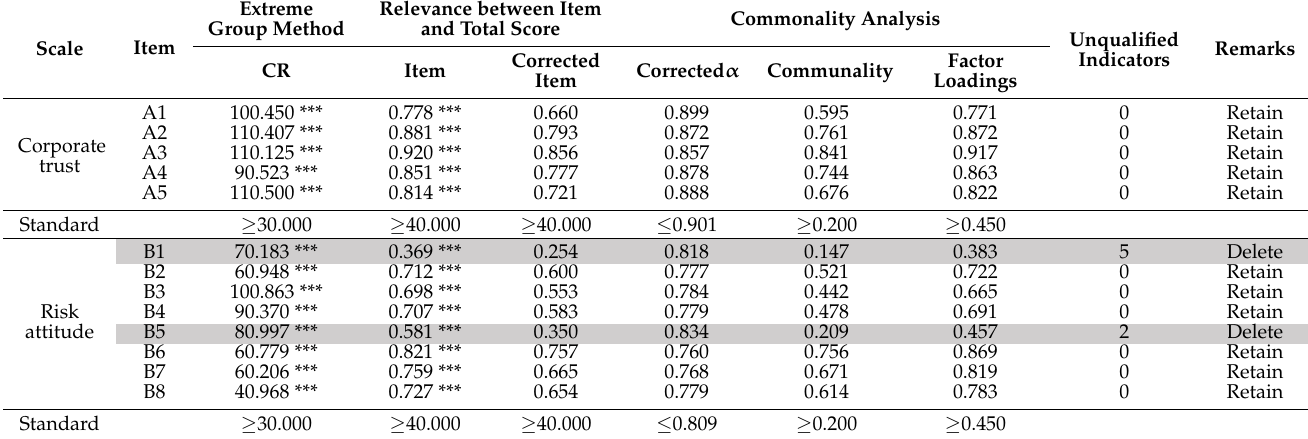
Table 1. Item analysis of corporate trust and risk